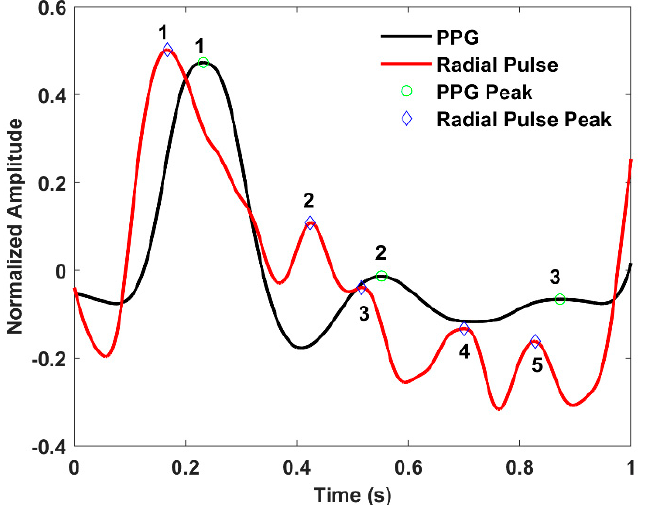
Figure 9. Comparison of the filtered PPG and the radial pulse waveform highlighting the number of peaks.